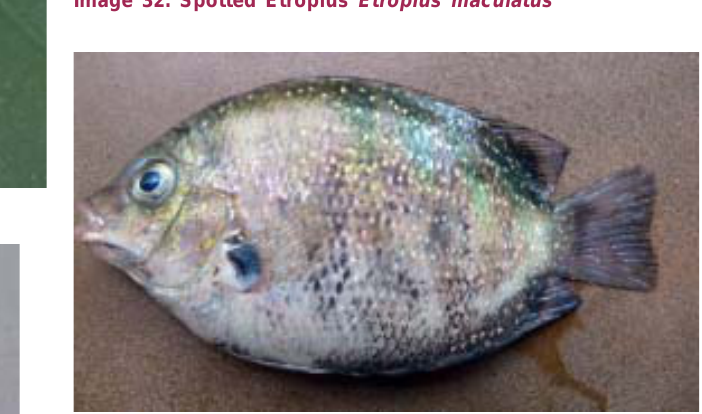
Image 33. Pearl Spot Etroplus suratensis